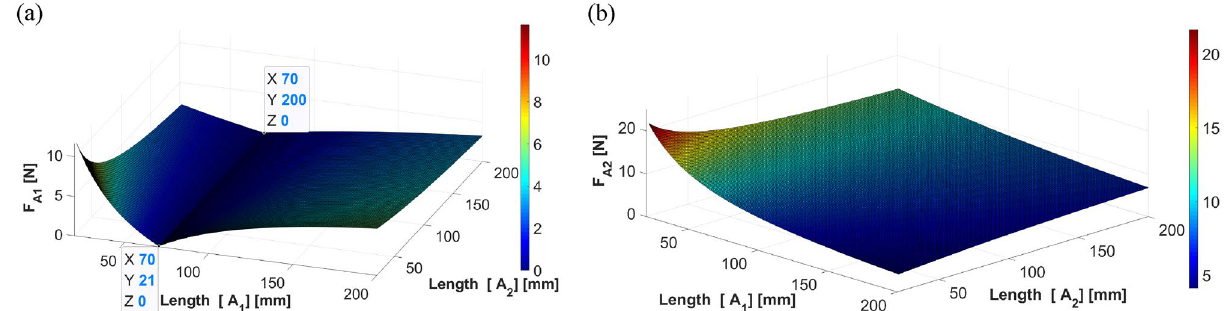
Figure 18. Control force of actuators 1 and 2 when the shaker is placed at 70 mm: ( a ) actuator 1; ( b ) actuator 2 ( generated with MATLAB R2018b, https:// mathw orks. com).